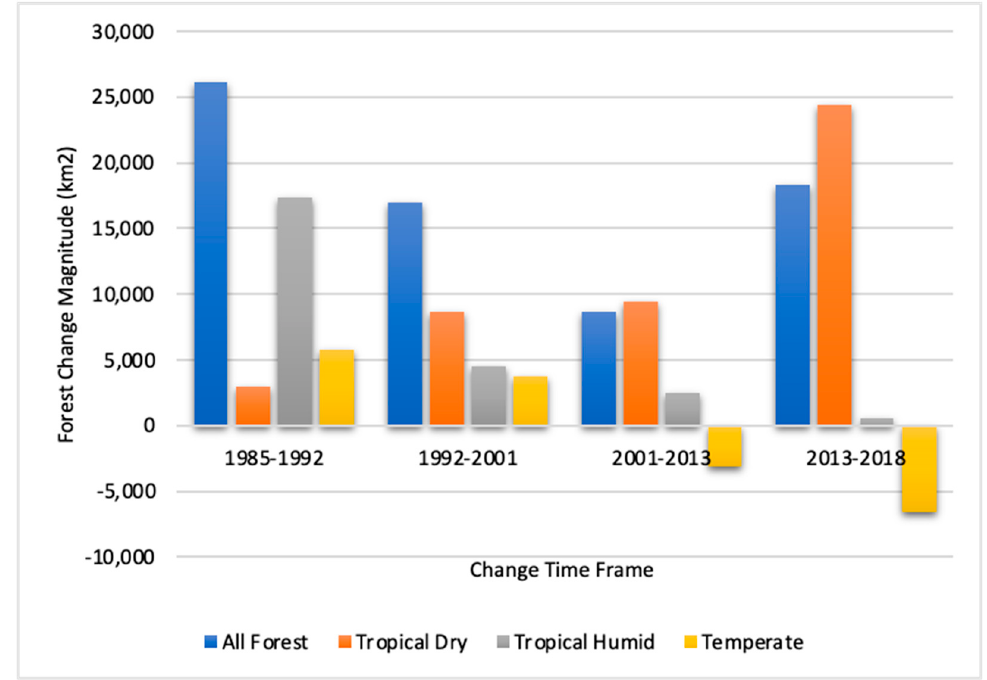
Figure 1. Forest change magnitudes 1985–2018 km 2 [45]. Five study sites in PLW, located in Micho- acán state, central